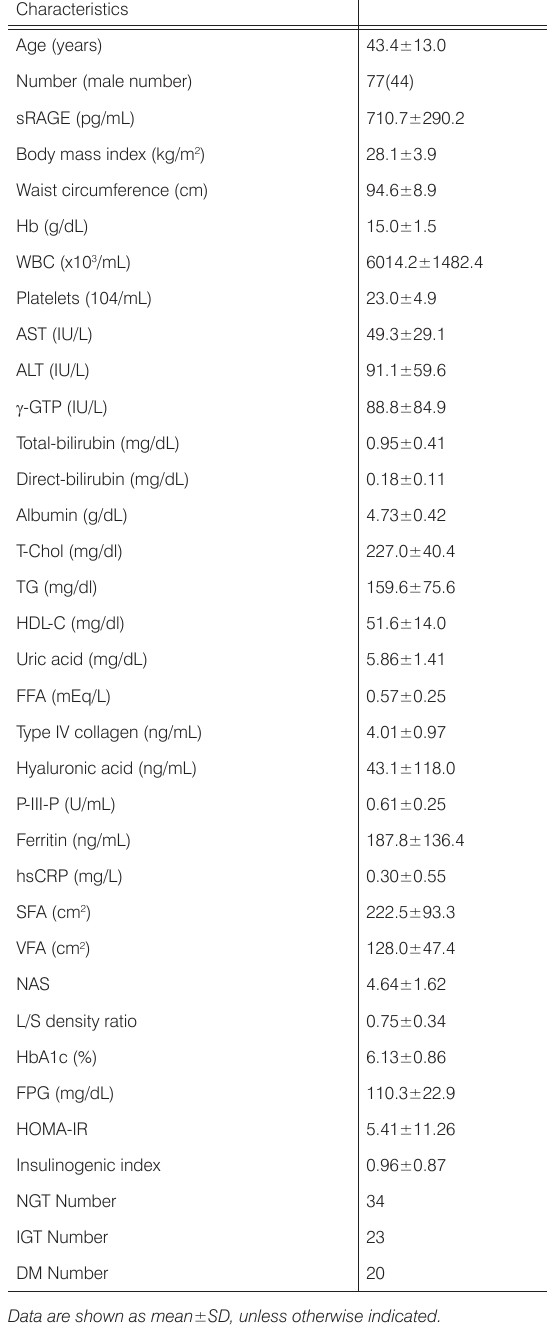
Table 1. Clinical variables of patients